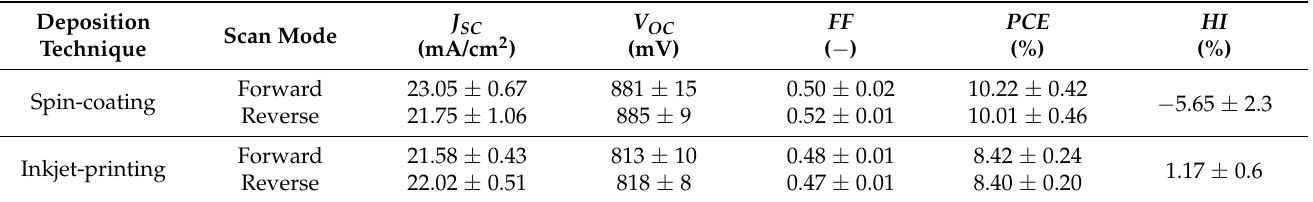
Table 1. Electrical characteristics of the solar cells fabricated by the different deposition techniques of the perovskite absorbent layer.